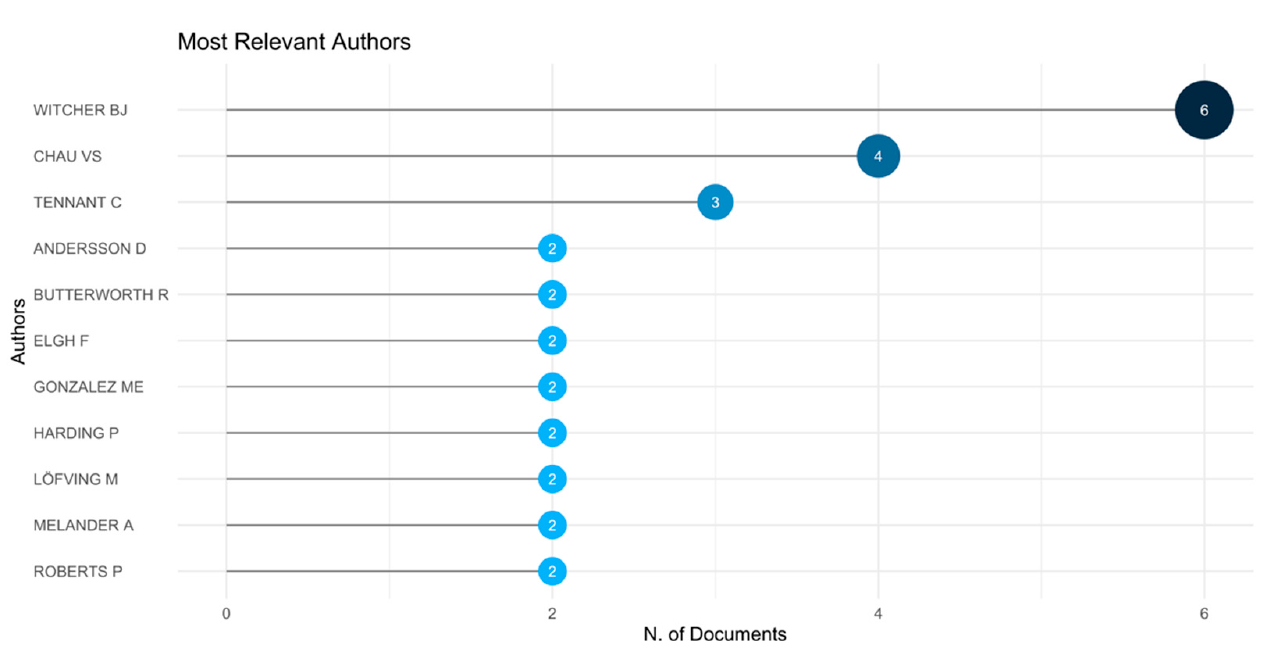
Figure 4. Most productive authors.